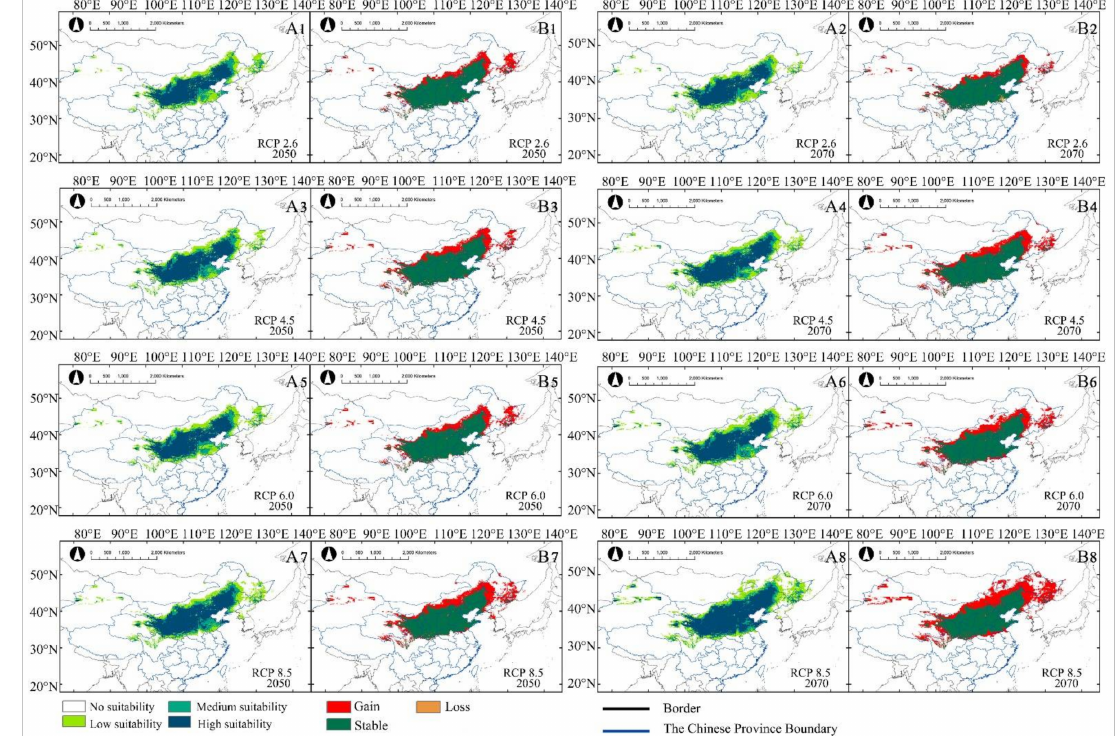
Figure 5. Under future climate change scenarios (2050s and 2070s), ( A1 − A8 ) are potentially suitable distributions of X. sorbifolium . ( B1 − B8 ) are the area changes of X. sorbifolium compared to the distribution under current climate